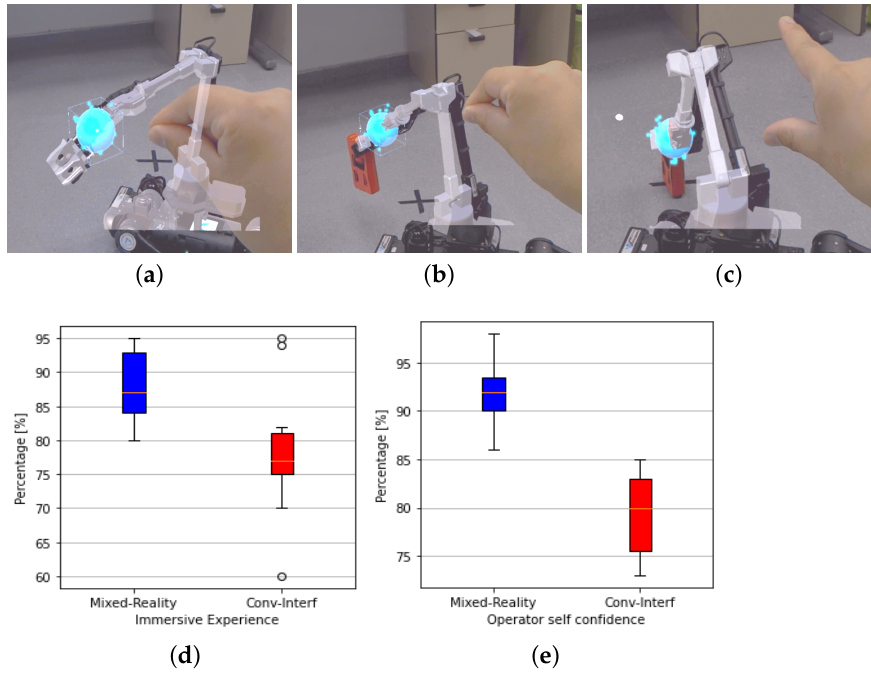
Figure 5. Tests to evaluate the Mixed-Reality efficiency system, the operator holds the robots end (blue ball) and using his gestures, moves it towards the destination (X Mark). ( a ) Tele-operation in home position. ( b ) Tele-operation in 2nd Pose. ( c ) Tele-operation to final position. ( d ) Immersive experience analysis. ( e ) Operator confidence analysis.